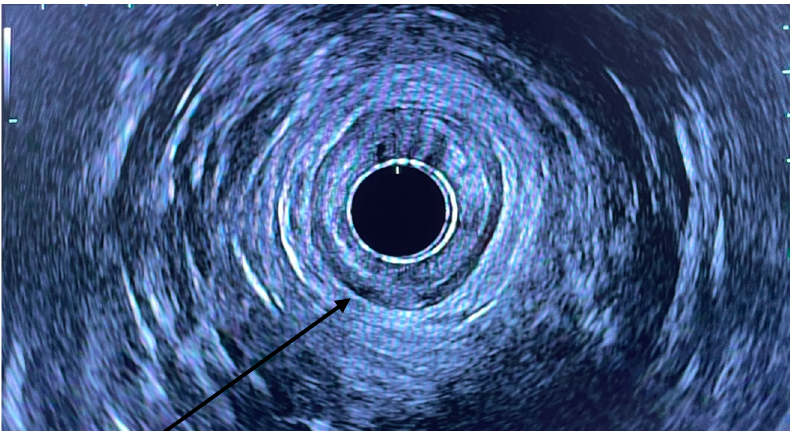
Figure 1. Radial EUS with arrow pointing to IAS.